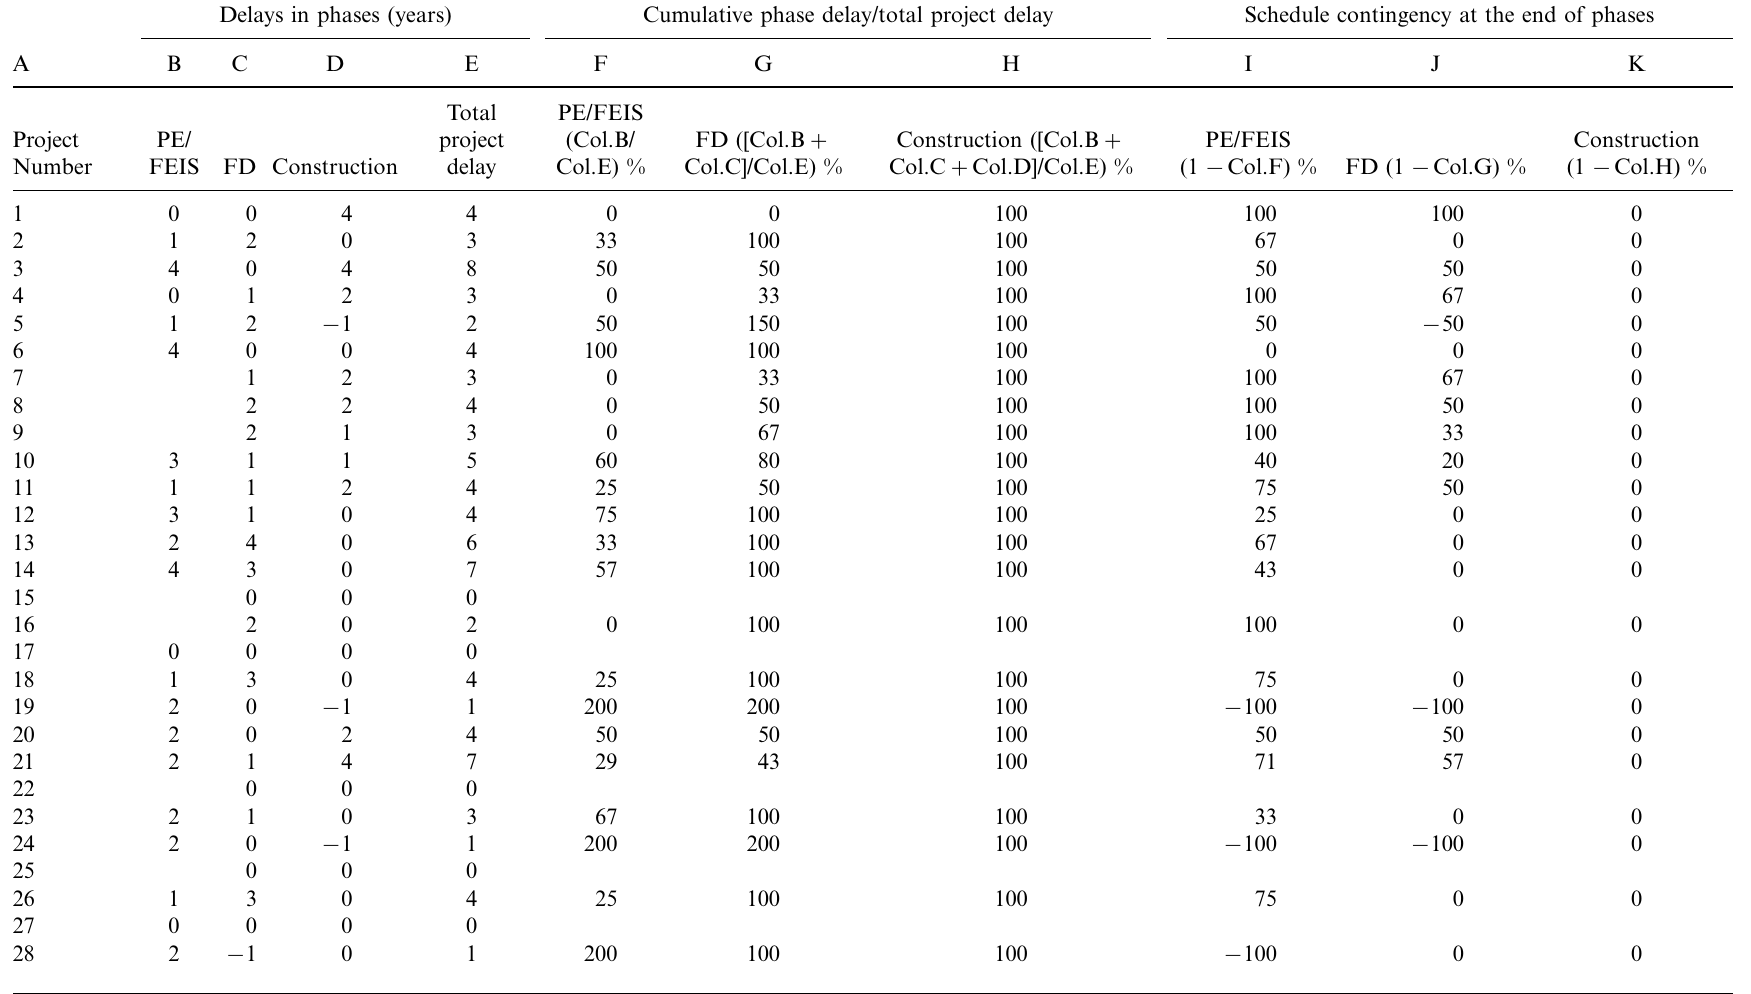
Table 2. Schedule contingencies at the end of each phase Delays in phases